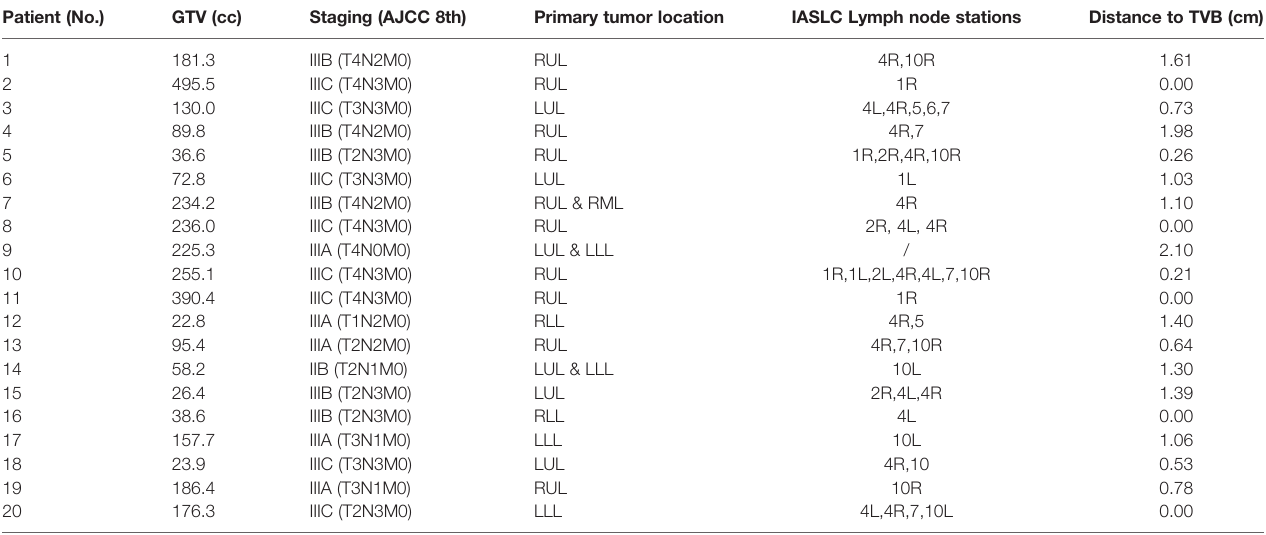
TABLE 1 | Disease characteristics of the twenty proxy cases. Patient